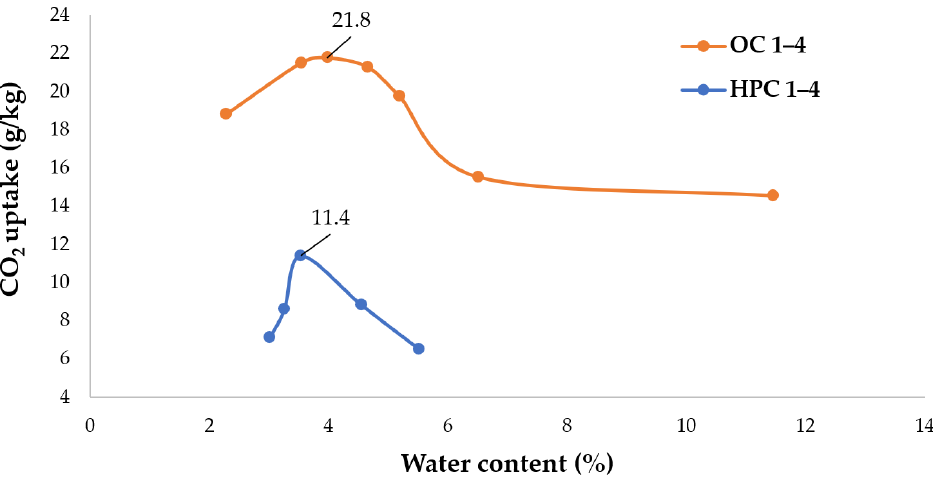
Figure 8. Effect of the RCA type on CO 2 uptake as a function of the water content (one accelerated carbonation test for these RCAs at these water